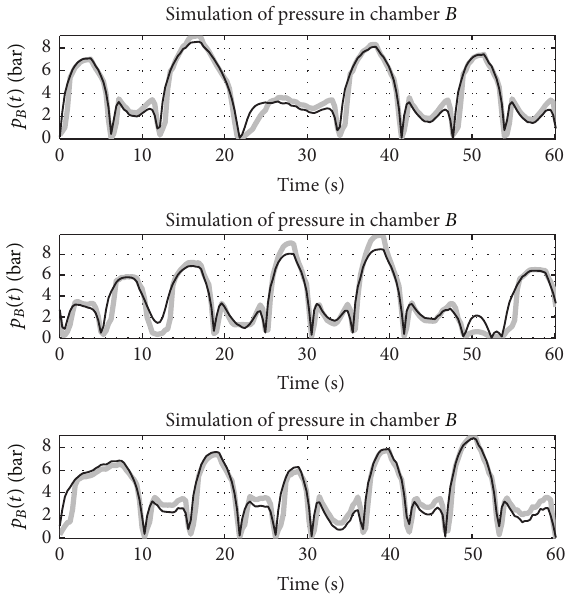
Figure 10: Validation results. The data presents a comparison of the measured pressure 𝑝 𝐵 (grey signal) with the estimation ̂𝑝 𝐵 (bold signal) found according to the model